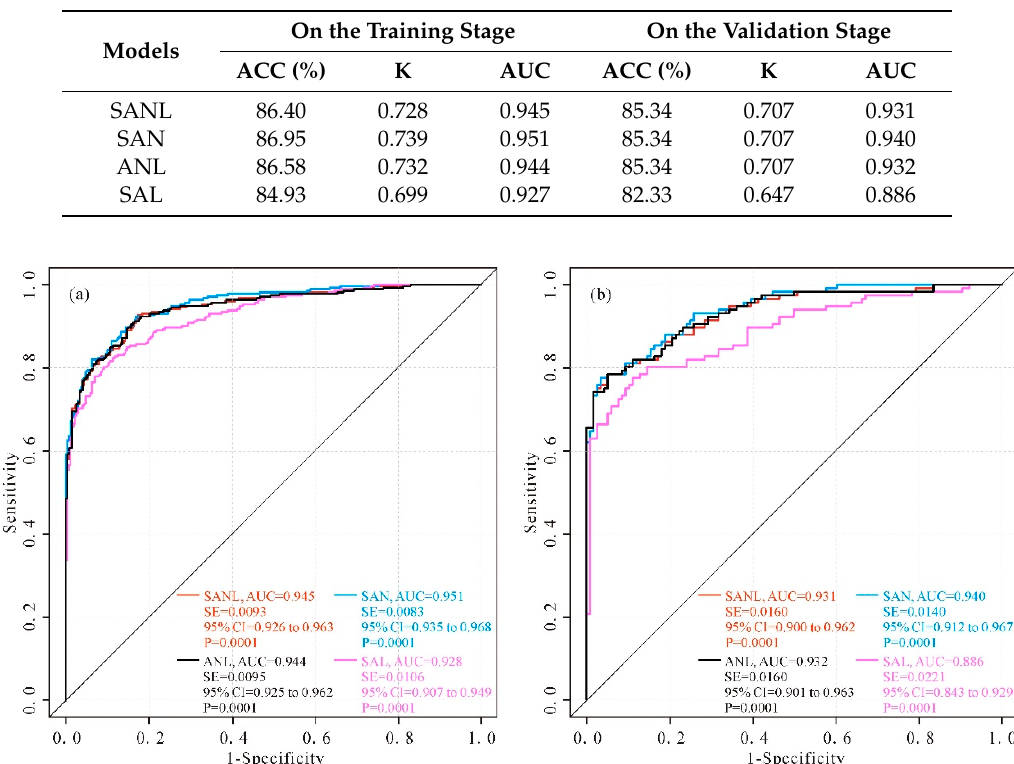
Figure 10. ROC analysis of four ensemble models ( a ) on the training dataset, ( b ) on the validation dataset. SE: standard error of the AUC; CI: confidence interval of the AUC; p : significance level.